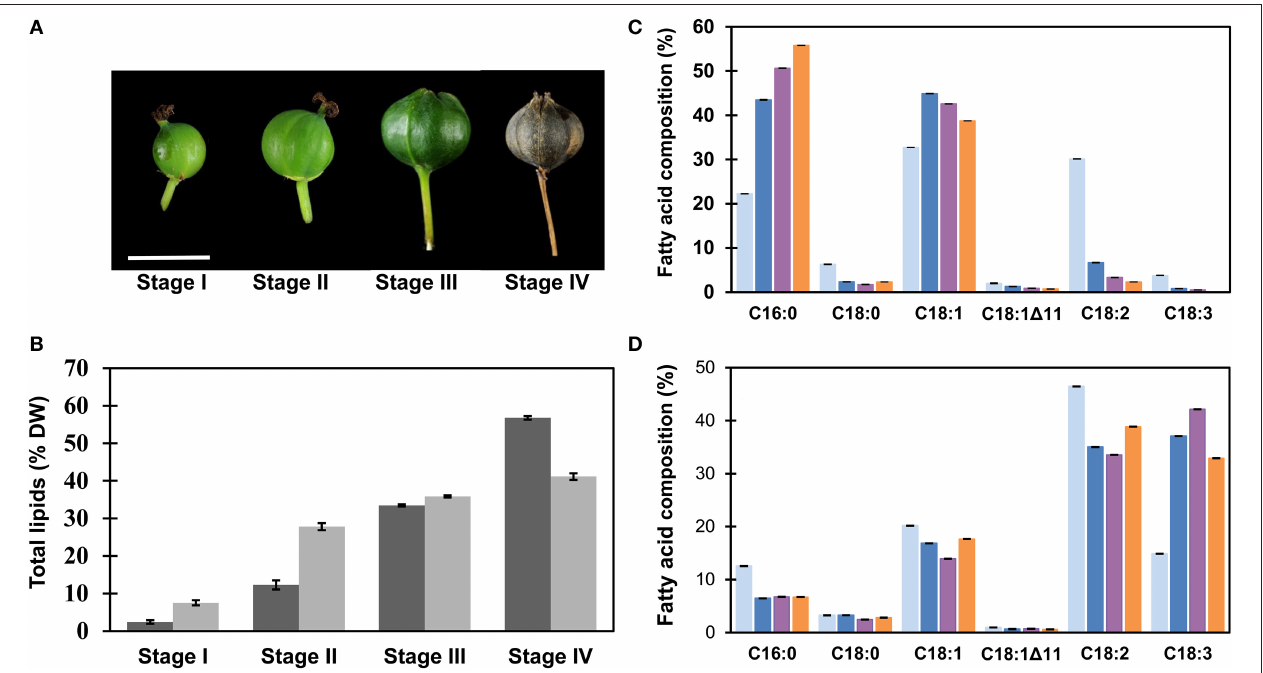
FIGURE 1 | Analysis of total lipids during fruit development of Triadica sebifera . (A) Sampling stages. Fruit development period was divided into four stages, including stage I (58 DAA), II (76 DAA), III (91 DAA), and IV (120 DAA). Scale bar = 10mm. (B) The contents of total lipids in mesocarp (dark) and seed kernel (shade) tissues in T. sebifera during fruit development on the basis of dry weight (DW). (C) Fatty acid composition of the total lipids isolated from developing T. sebifera mesocarp during fruit development. Stage I (gray), stage II (blue), stage III (purple), and stage IV (orange). (D) Fatty acid composition of the total lipids isolated from developing T. sebifera seed kernels. Stage I (gray), stage II (blue), stage III (purple), and stage IV (orange). Mean ± Standard deviation ( n =